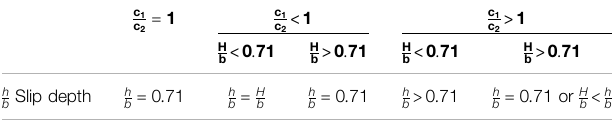
TABLE 2 | Range of slip